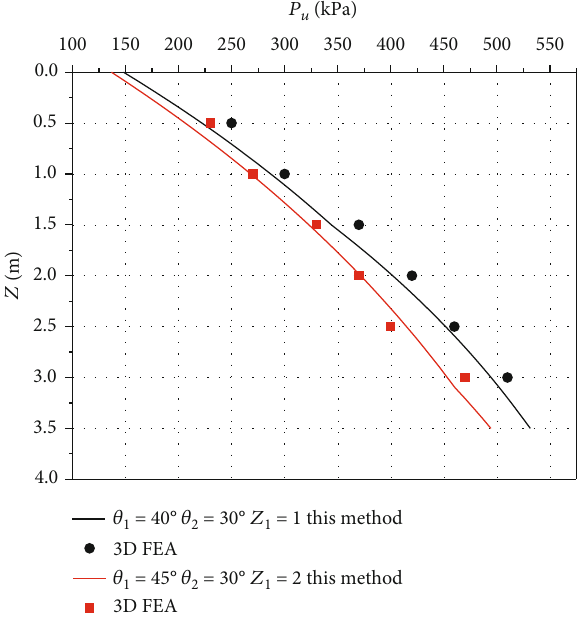
= 50 ° . (b) Considering θ = 40 ° . 1 1